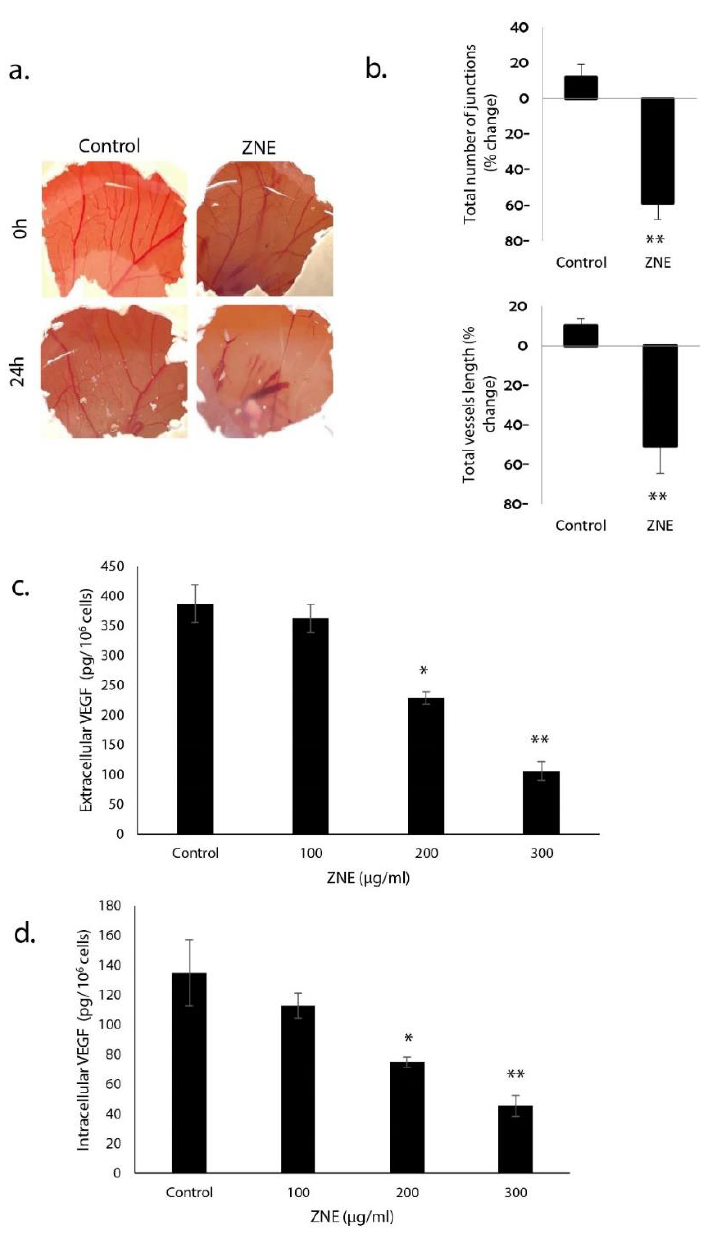
Figure 8. Ziziphus nummularia inhibits angiogenesis in ovo and reduces extracellular and intracellular VEGF levels in Capan-2 cells. ( a ) ZNE was applied on the CAM of fertilized eggs as described in Materials and Methods, and the angiogenic response was scored by taking pictures of the CAM after 24 h. ( b ) Percentage changes in total vessel length and total number of junctions, for both control and ZNE-treated CAMs, were quantified using the AngioTool software. ( c ) Cells were treated with or without the indicated concentrations for ZNE for 24 h, and the levels secreted VEGF in the conditioned medium were analyzed by ELISA as described under Materials and Methods. ( d ) Similarly, levels of intracellular VEGF were analyzed by ELISA. Data represent the means ± SEM of three independent experiments. * denotes p < 0.05 and ** p <